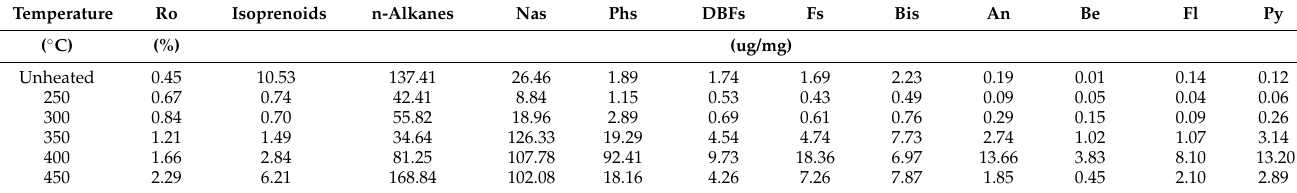
Table 2. Characteristics of concentration distribution of alkanes and aromatics in simulated experi- mental products.